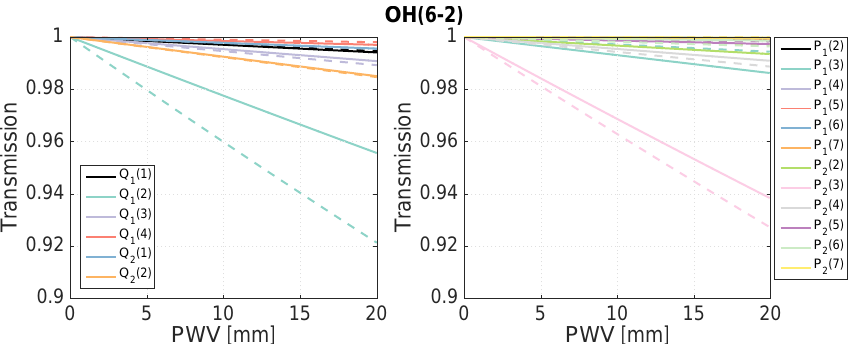
Figure 7. Water vapour transmission of the OH(6–2) lines as a function of precipitable water vapour (PWV). The left panel shows the Q-branch lines and the right panel, the P branch. Solid lines represent the e component of the lambda-doubled line, and the dashed lines represent the f component.